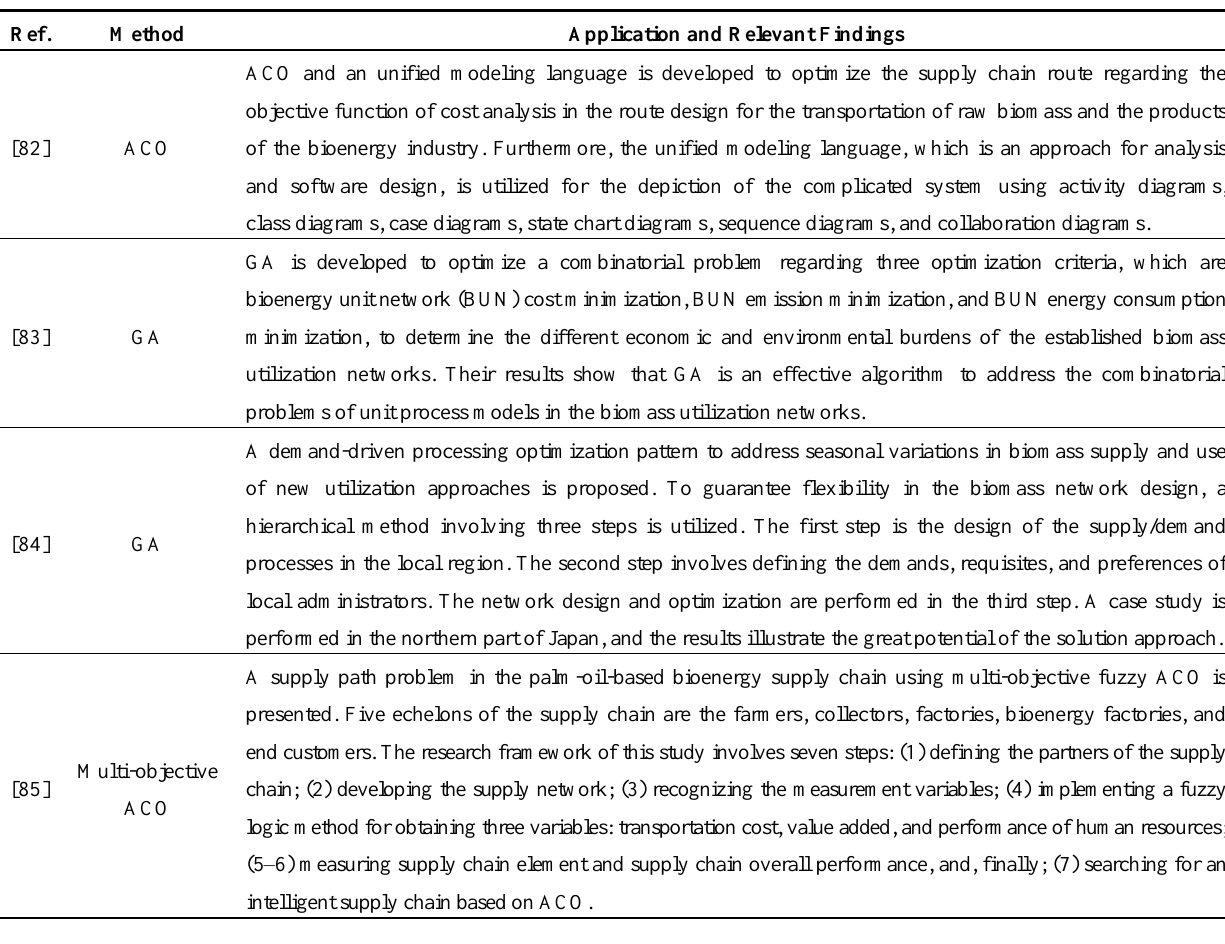
Table 8. Reviewed articles in the supply chain network design